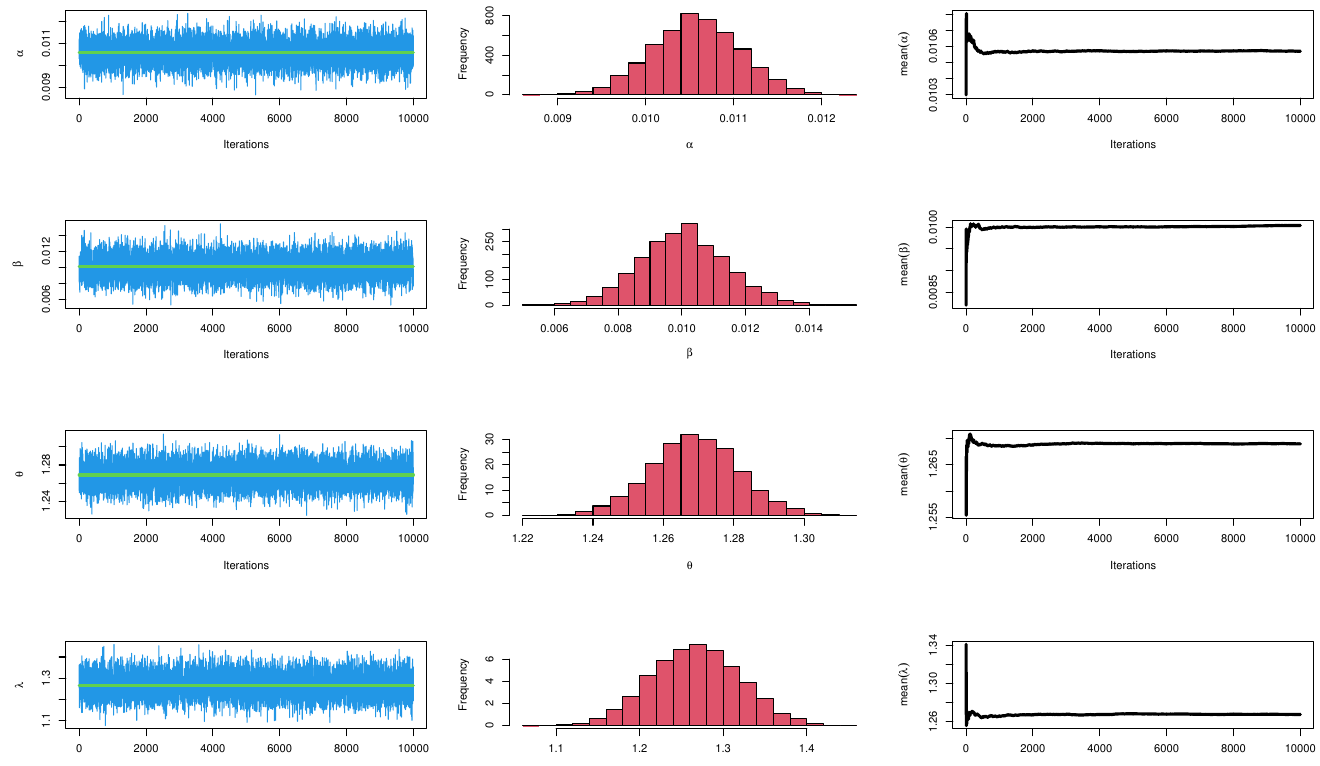
Figure 9. MCMC plots for parameters of TLMW model for COVID-19